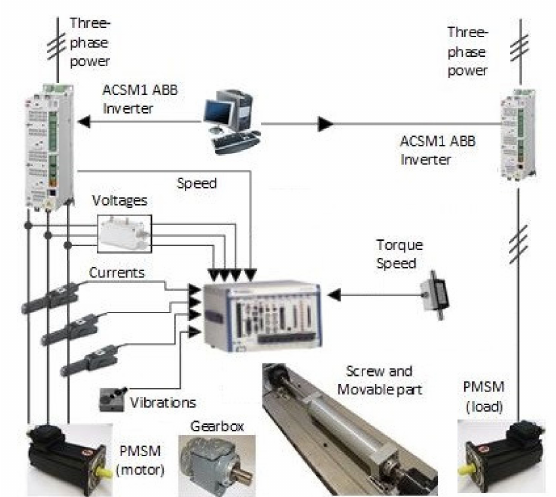
Figure 4. Test bench diagram used for the study of the fault